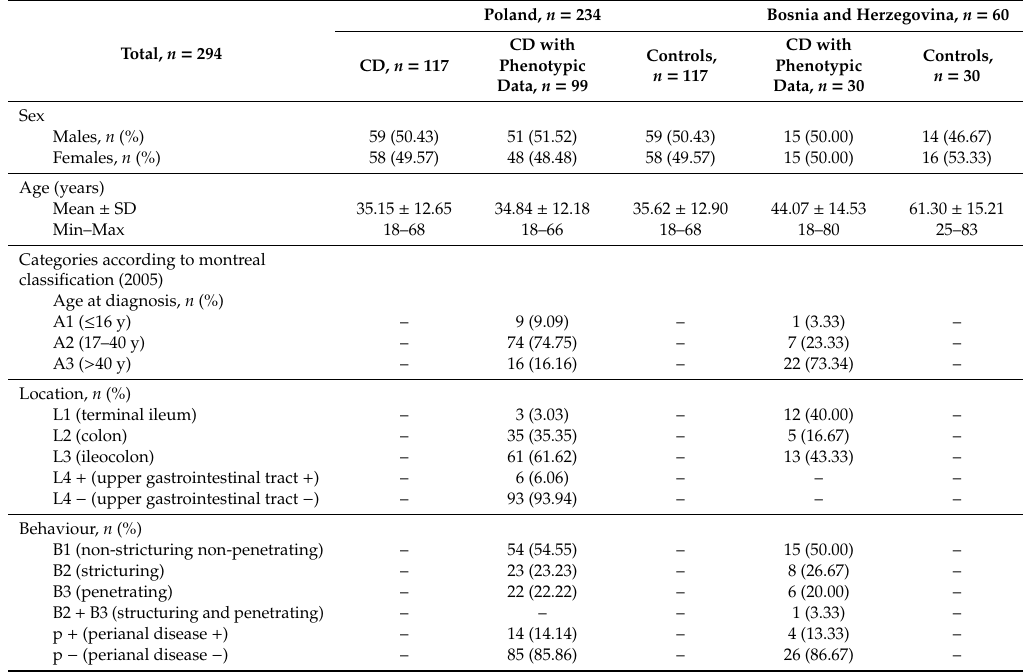
Table 1. Characteristic of groups with and without